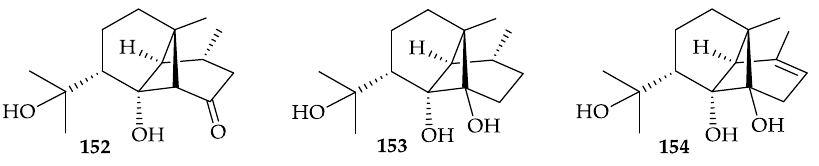
Figure 24. Structures of dendronephthols A–C ( 152 – 154 ).